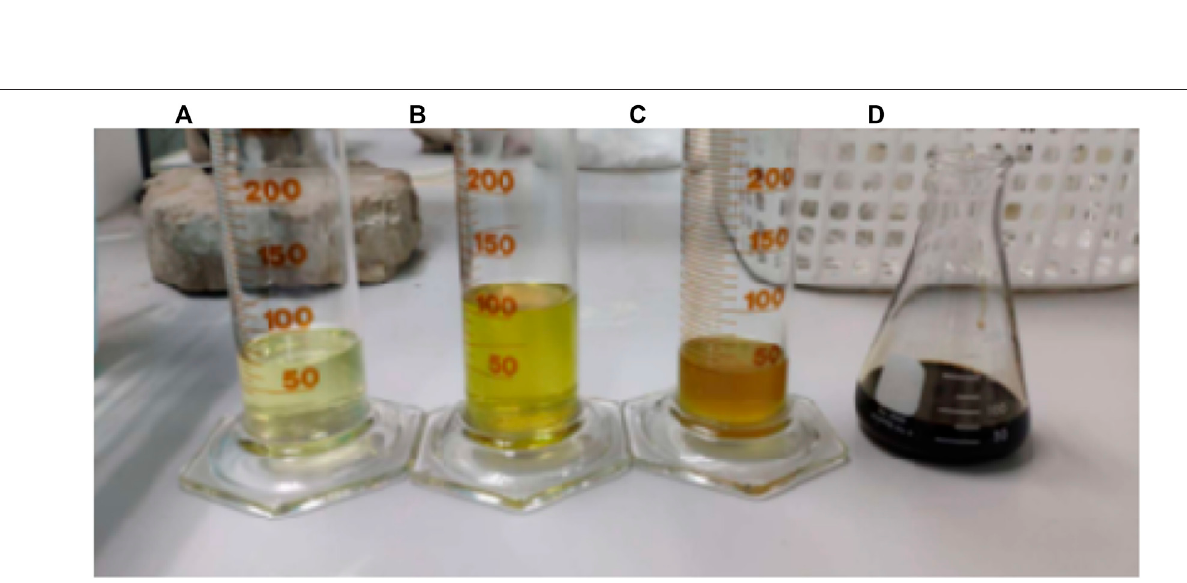
Frontiers in Energy Research |